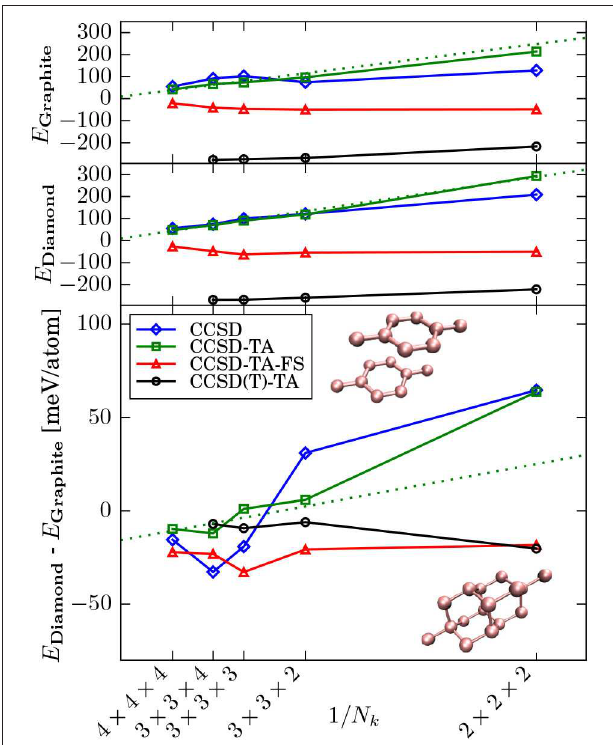
FIGURE 1 | This figure has been taken from Gruber et al. (2018). Convergence of the correlation energy (difference) to the thermodynamic limit with respect to the number of k -points ( N k ) for carbon graphite (top panel) , carbon diamond (middle panel) , and the difference between carbon diamond and graphite (bottom panel) . The dotted line represents the linear fit of the uncorrected values. (T) corrections (black) are on top of CCSD-TA-FS energy obtained using a 4 4 4 k-point mesh (red). Zero-point energies are included, × × and they stabilize graphite compared to diamond by 9